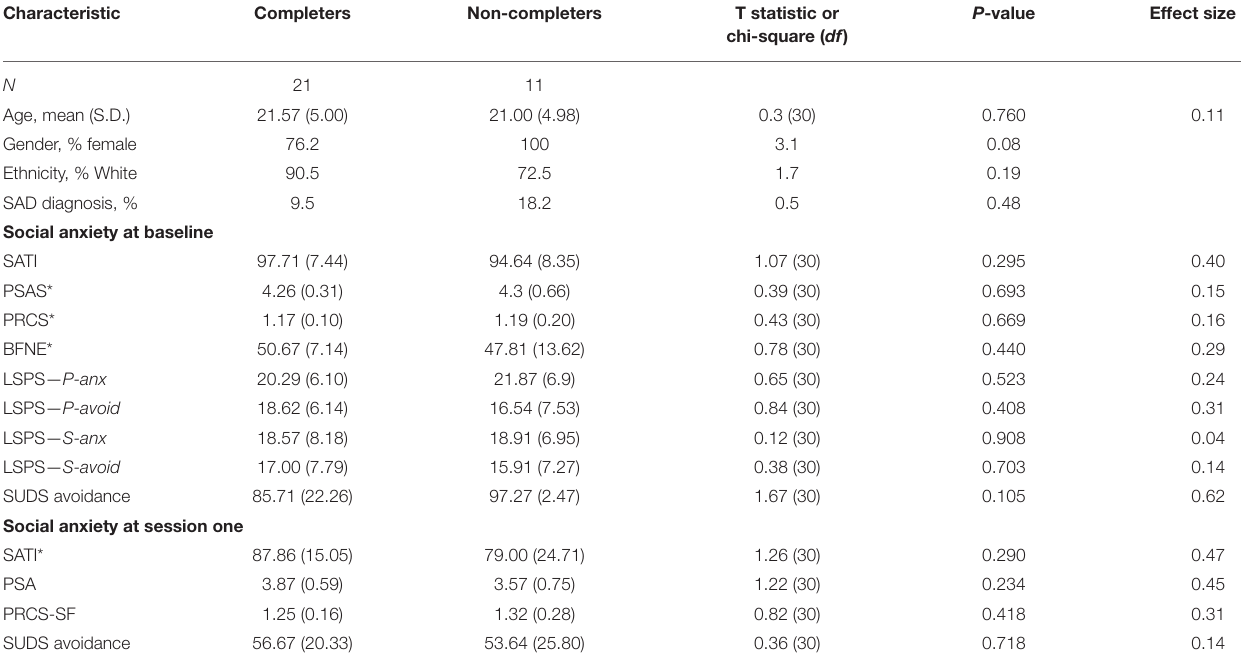
TABLE 1 | Demographic characteristics and social anxiety of completers ( n = 21) and non-completers ( n = 11). Characteristic